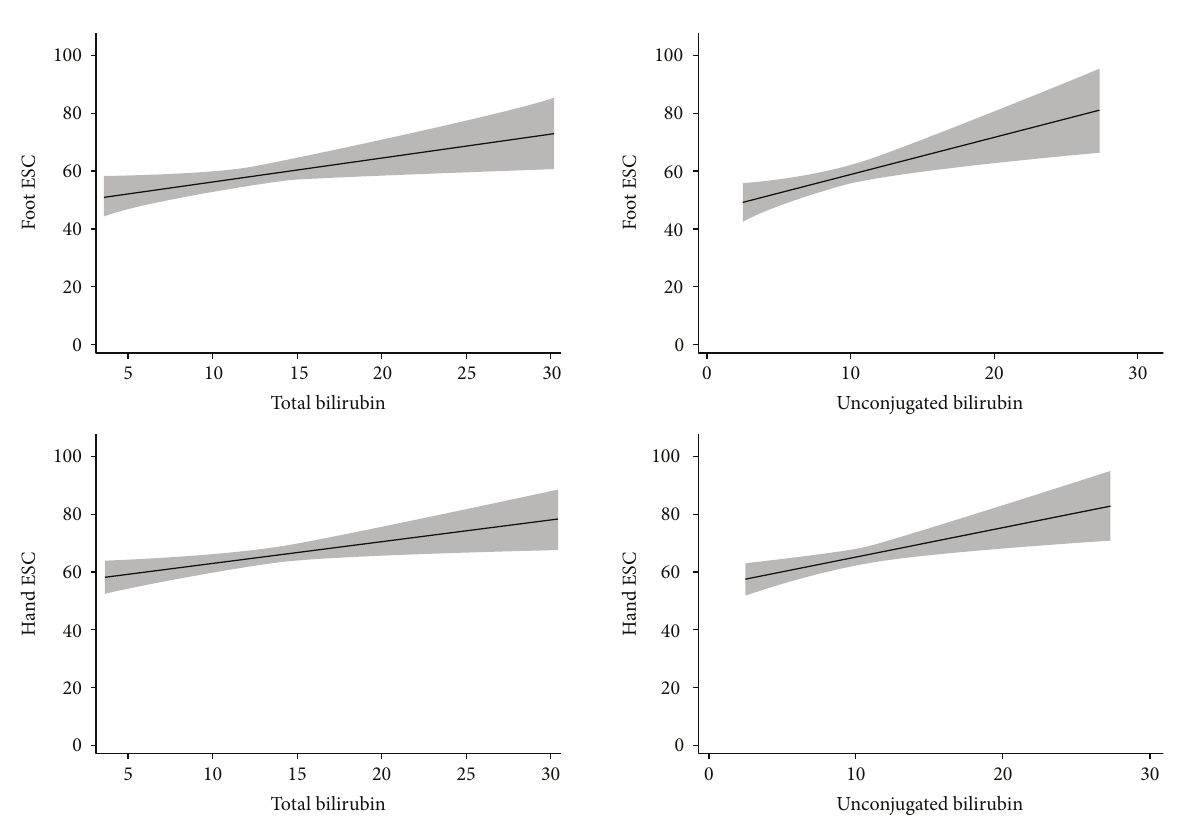
Figure 1: Multiple linear regression analysis of association between total and unconjugated bilirubin levels and hand and foot ESC levels detected by the